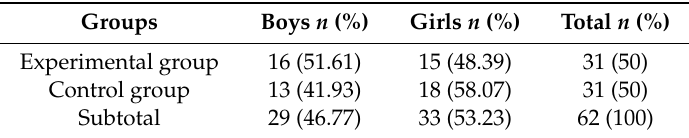
Table 1. Study groups by